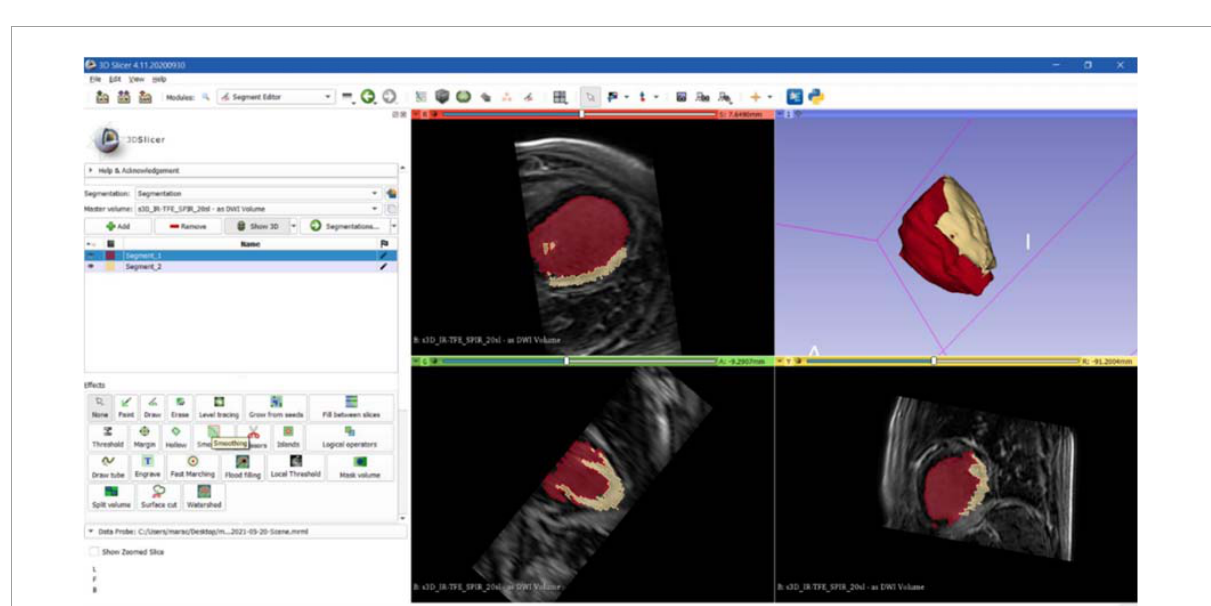
FIGURE4 CMR segmentation. Axial, sagittal, coronal, and 3D views of CMR segmentation on the 3D Slicer software: the yellow zone represents the target area (scar), the red one represents the healthy